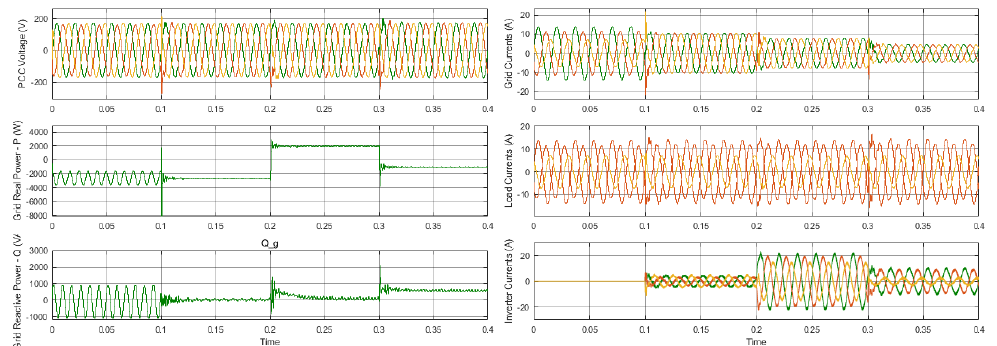
Figure 8. MATLAB/SIMULINK results.